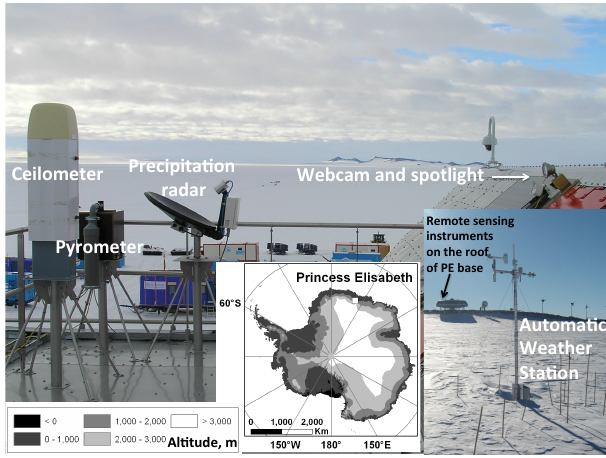
Figure 1. The cloud–precipitation–meteorological observatory HY- DRANT at the Princess Elisabeth base in East Antarctica. Shown on the figure are the ceilometer, the infrared pyrometer, the verti- cally profiling precipitation radar, the webcam with spotlight and the automatic weather station (right lower inset). The middle inset shows the location of the PE station on the Antarctic ice sheet (white square) together with the orography (metres above sea